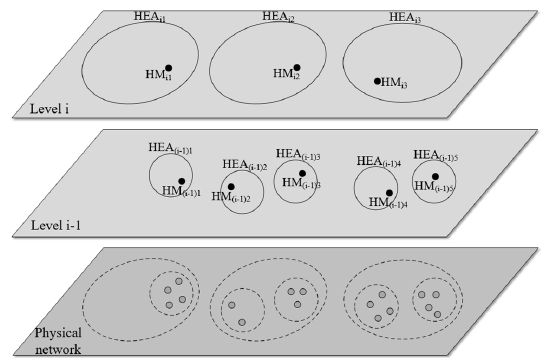
Figure 1. The nested structure of deterministic latency name resolution (DLNR). The physical network is partitioned into several hierarchical elastic areas (HEAs). These HEAs are nested organized, and each HEA has an HEA Manager (HM) to provide a name-resolution service. Each layer is constrained by an upper bound of latency.